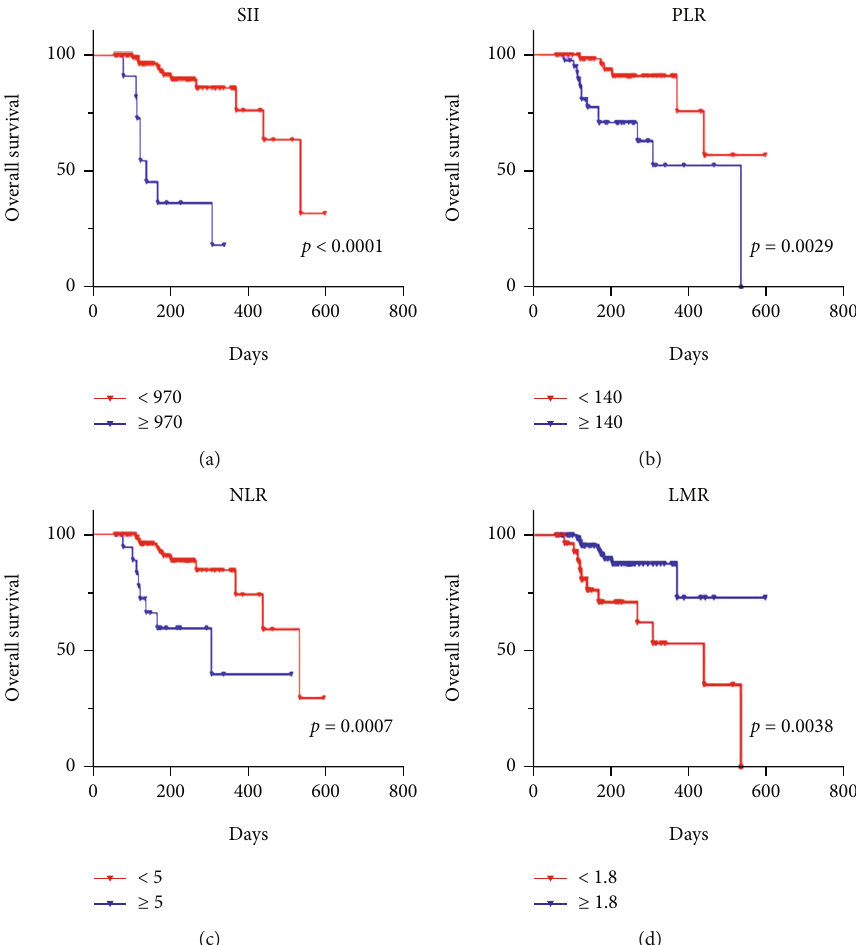
Figure 3: The Kaplan – Meier survival curves indicated that elevated SII, PLR, and NLR were associated with decreased OS (a – c). Conversely, decreased LMR was associated with decreased OS